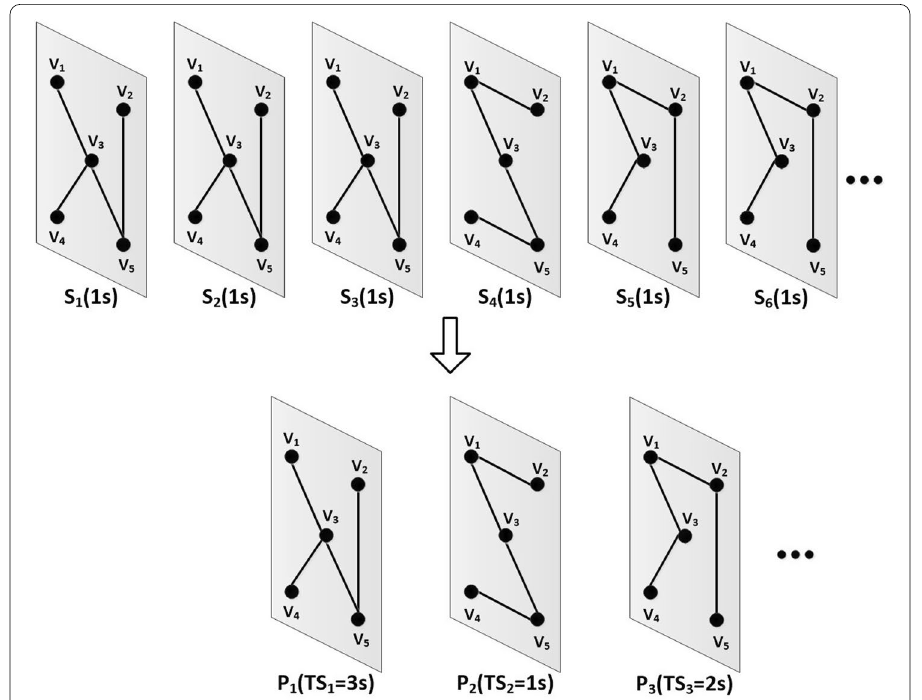
Fig. 3 Diagram of merging identical time